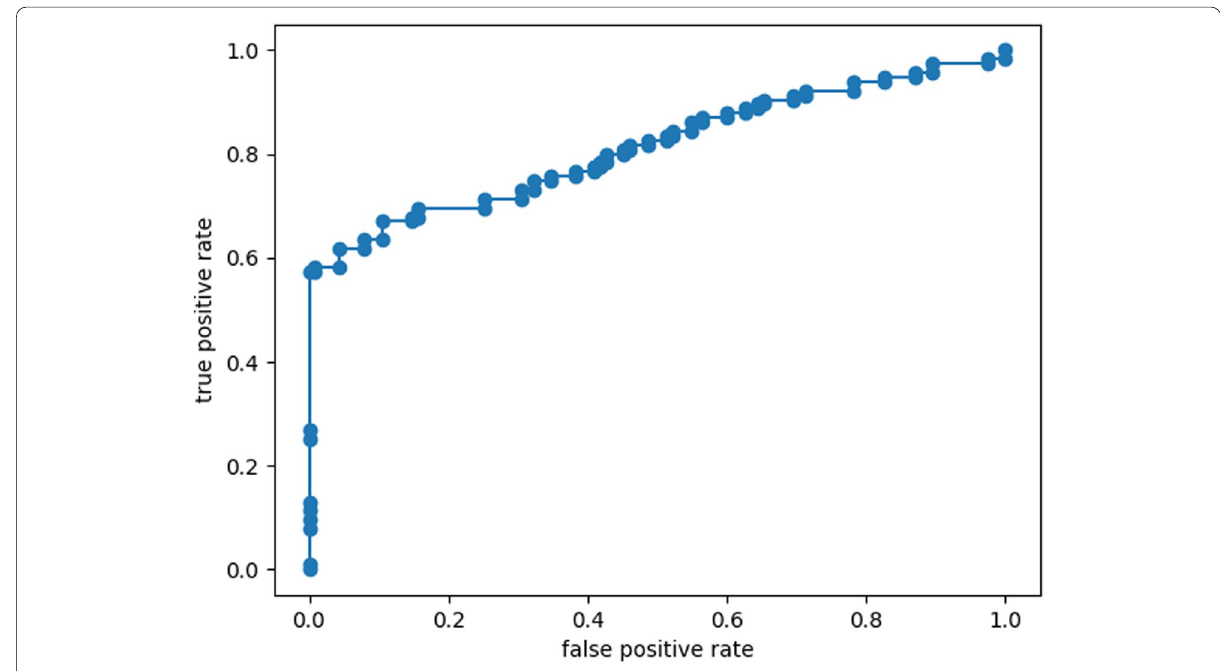
Fig. 4 ROC curve of test